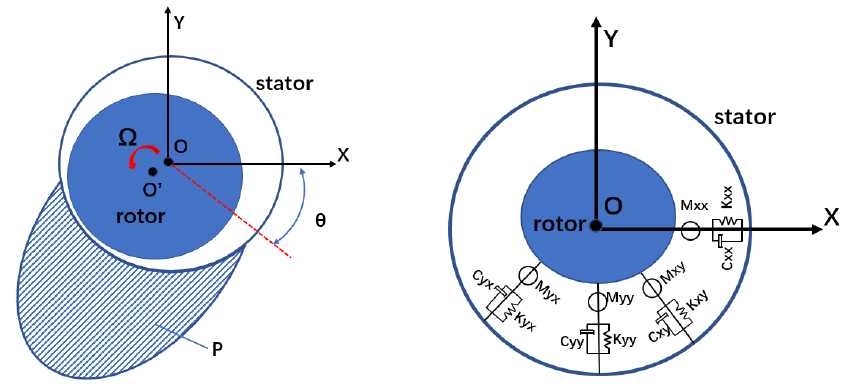
Figure 1. Schematic diagram of the annular seal rotordynamic characteristics.